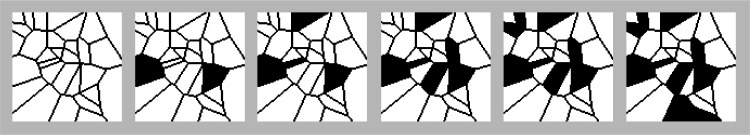
Illustration of how set-asides were added into the landscape.The left hand panel shows a 101 × 101 cell landscape generated using 30 randomly placed field seeds, where white cells represent agricultural crops and black cells represent wild land or hedgerows. Set-aside fields are added by randomly selecting fields containing agricultural crops, and resetting the cells within the field as wild land. Moving from left to right, each successive panel has two additional agricultural fields redesignated as set-aside. Note that this is a simplified sketch: the results described consider a larger landscape and add more than two fields at each assay point.